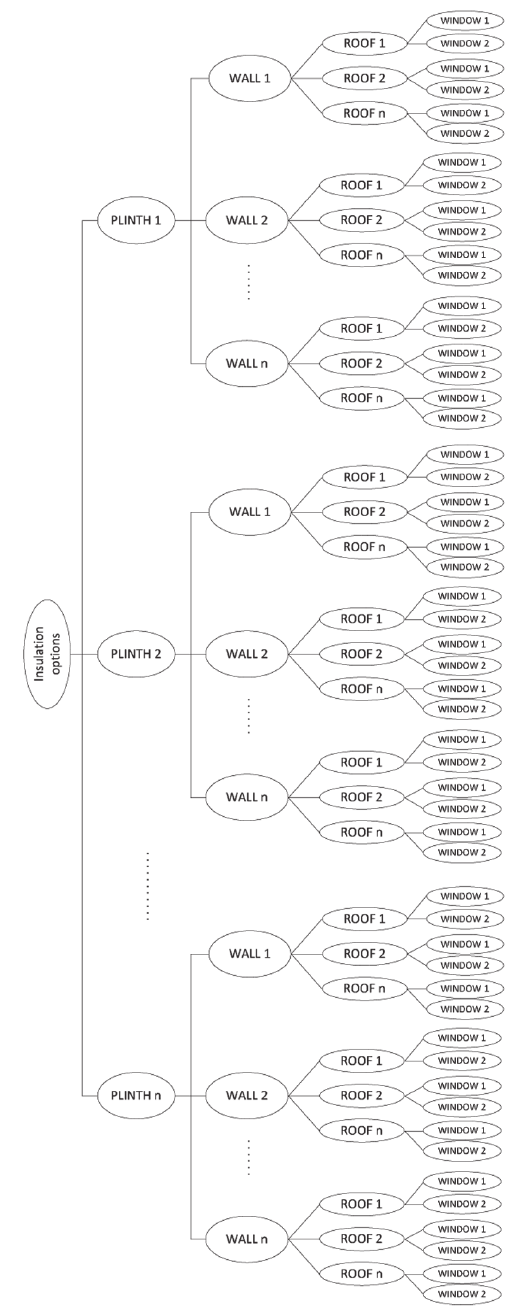
Fig. 2. a fragment of decision tree used for selection of alternative combinations of modernization measures